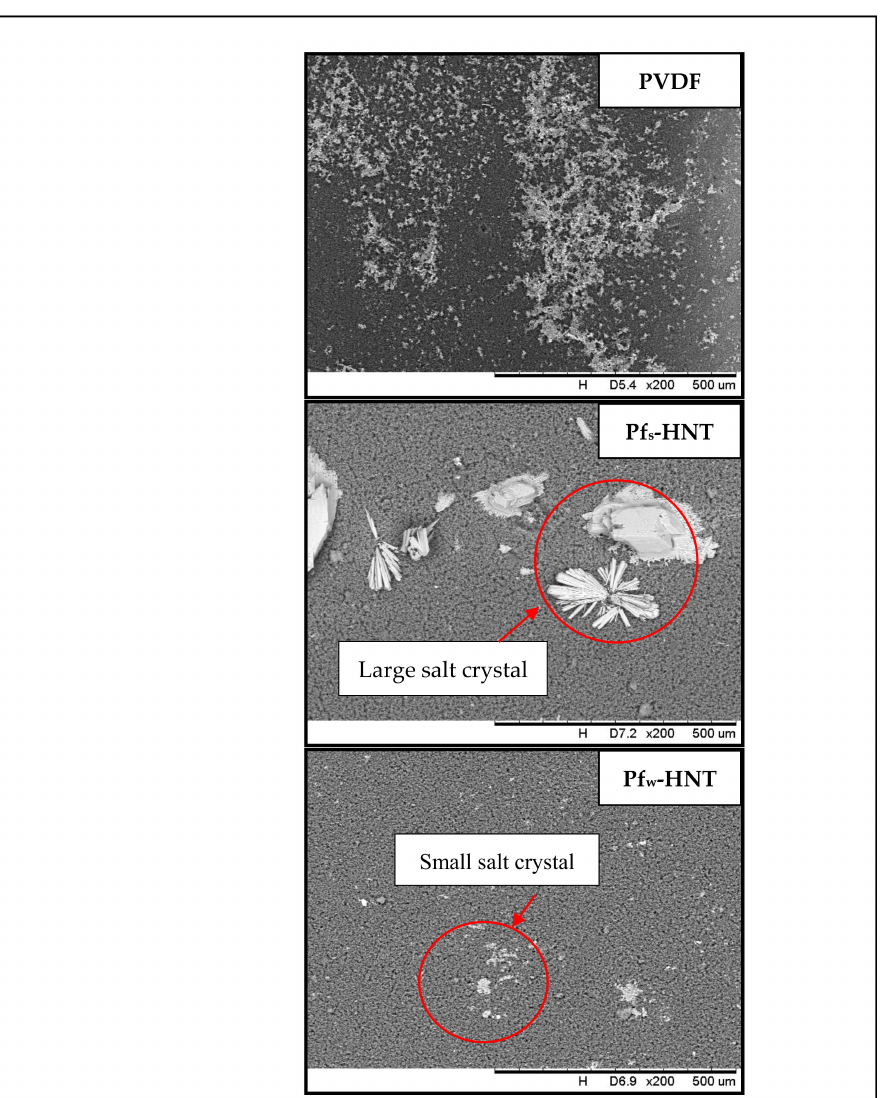
Figure 9. The reduction of salt scaling after introduction of functionalized HNT particles. Severe fouling on the surface of neat PVDF membrane was shown after 8 h of DCMD process. Addition of different functionalized HNTs had caused some adsorption of different size of salt crystals which indicated an improvement in anti-fouling